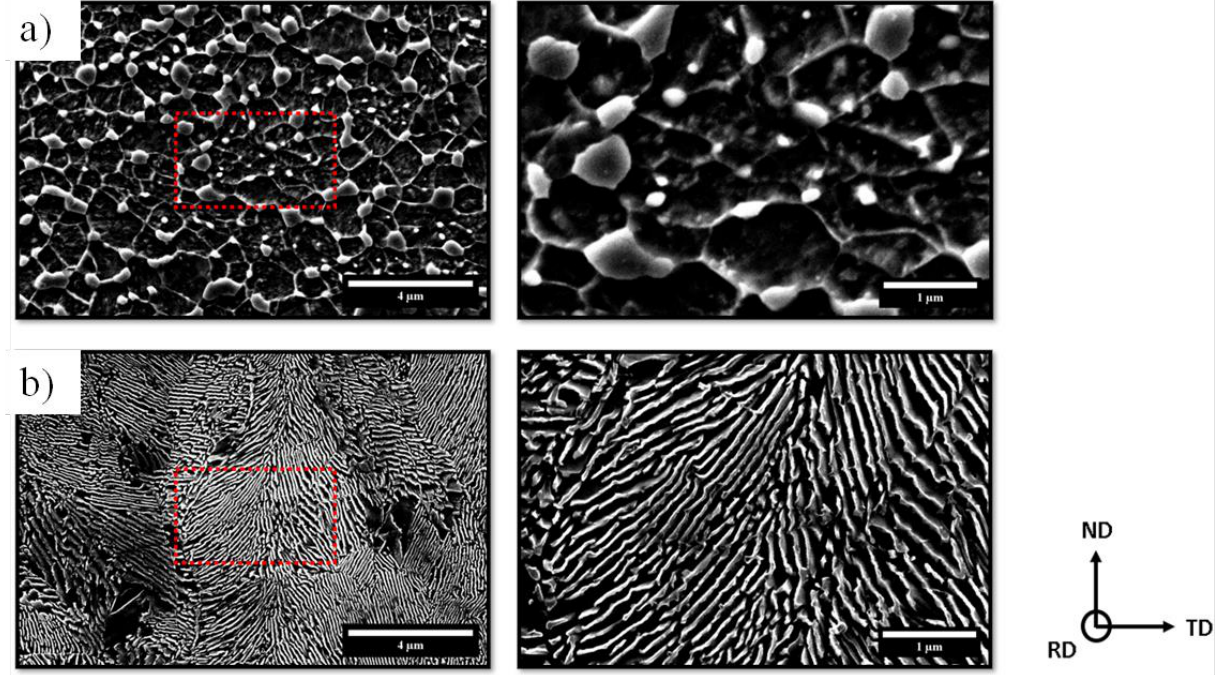
Figure 6. Micrographs of the heat-treated samples, labeled as ( a ): REC (spheroidized) and ( b ): ISO (lamellar).